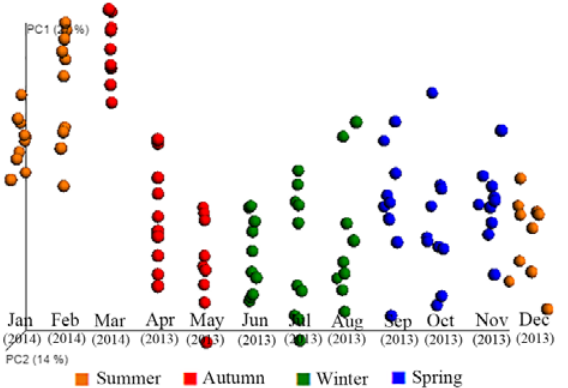
Figure 4. PCoA of the beta diversity of faecal bacteria in horses illustrated by season over a 12-month period. The graph shows the principal coordinate analysis (PCoA) of the beta diversity in the bacterial community; with each faecal sample represented as a dot (i.e., each dot represents a horse within a month). The principal coordinates explain 27% (PC1) and 14% (PC2) of the variation. The months of the year are shown on the horizontal axis and seasons are colour coded and categorised as